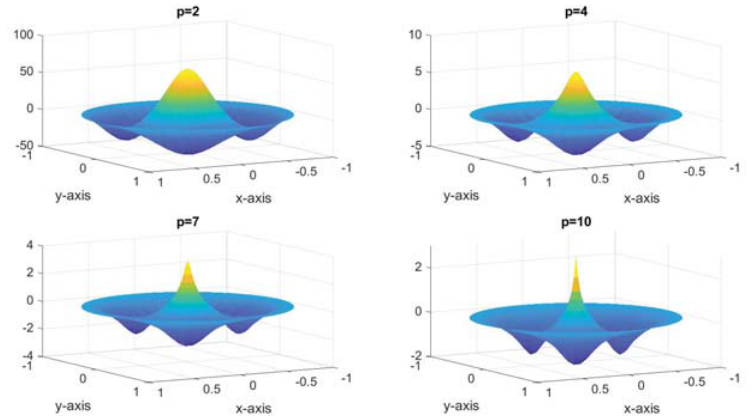
Fig. 4: Numerical solutions with two nodal regions and 3-symmetry